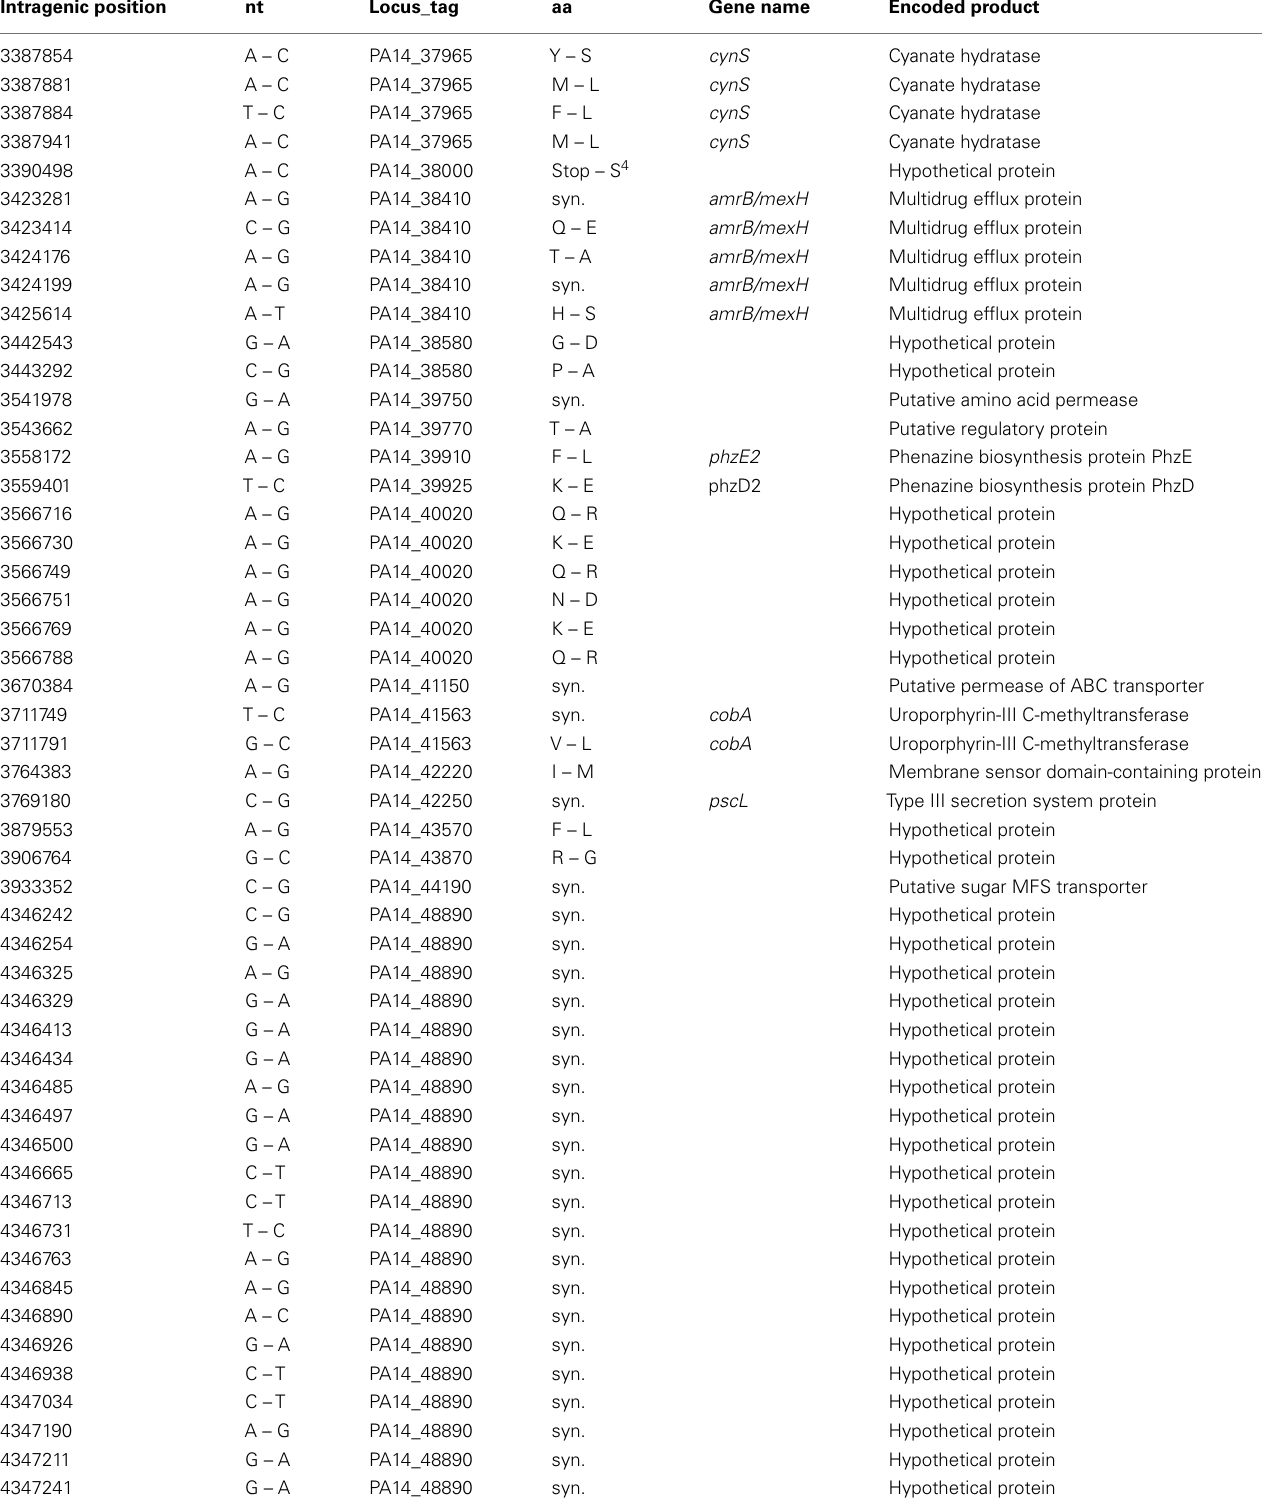
PA14_48890 syn. Hypothetical protein syn. Hypothetical protein syn. Hypothetical protein syn. Hypothetical protein syn. Hypothetical protein syn. Hypothetical protein syn. Hypothetical protein syn. Hypothetical protein syn. Hypothetical protein syn. Hypothetical protein syn. Hypothetical protein syn. Hypothetical protein syn. Hypothetical protein syn. Hypothetical protein syn. Hypothetical protein syn. Hypothetical